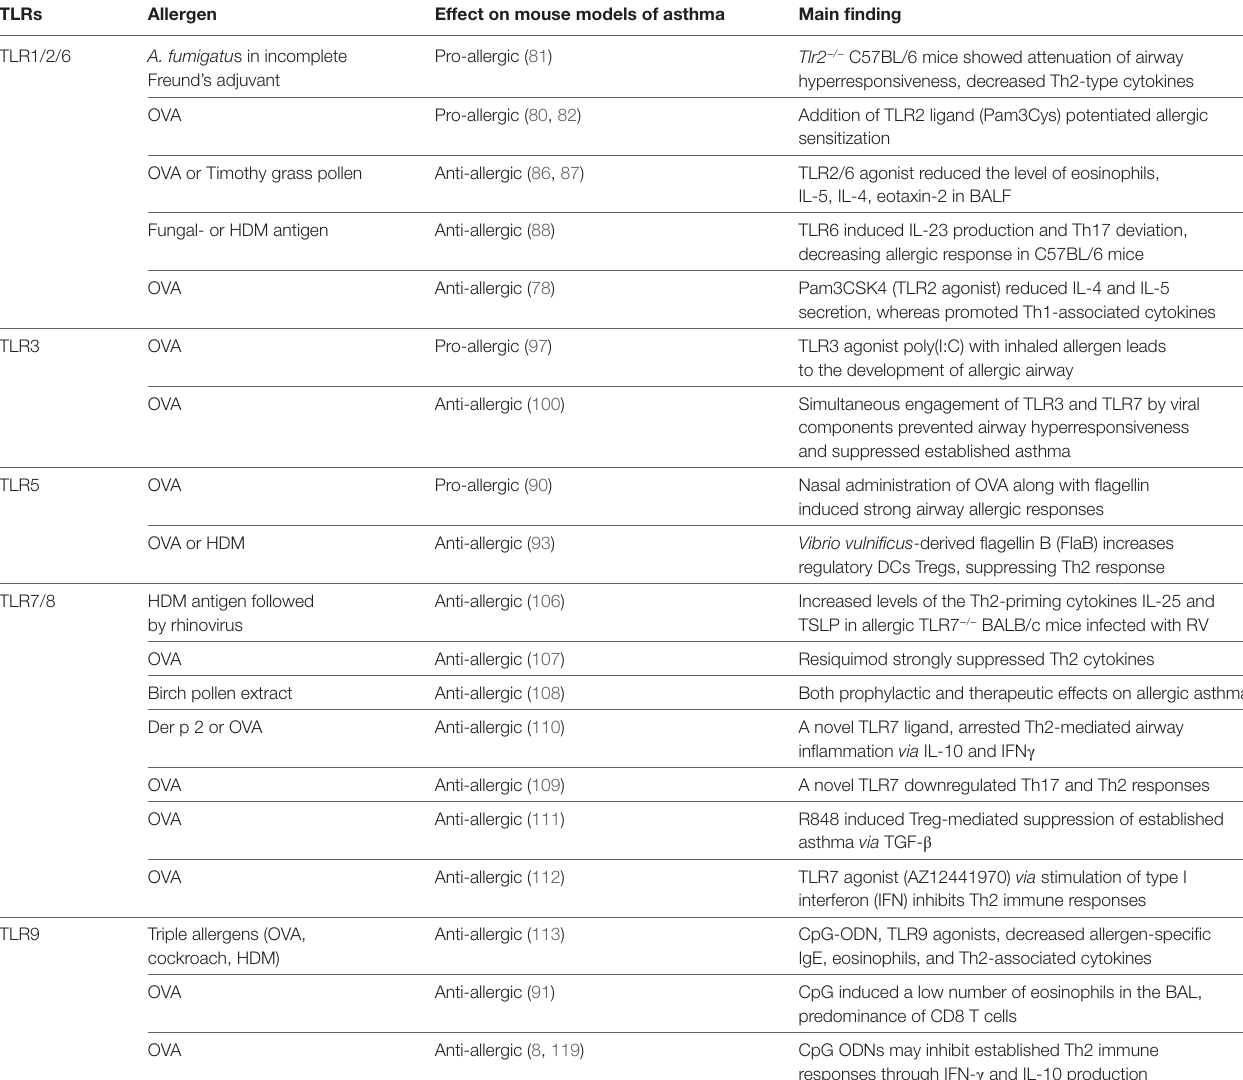
TABLe 1 | Involvement of TLRs in mouse experimental models of